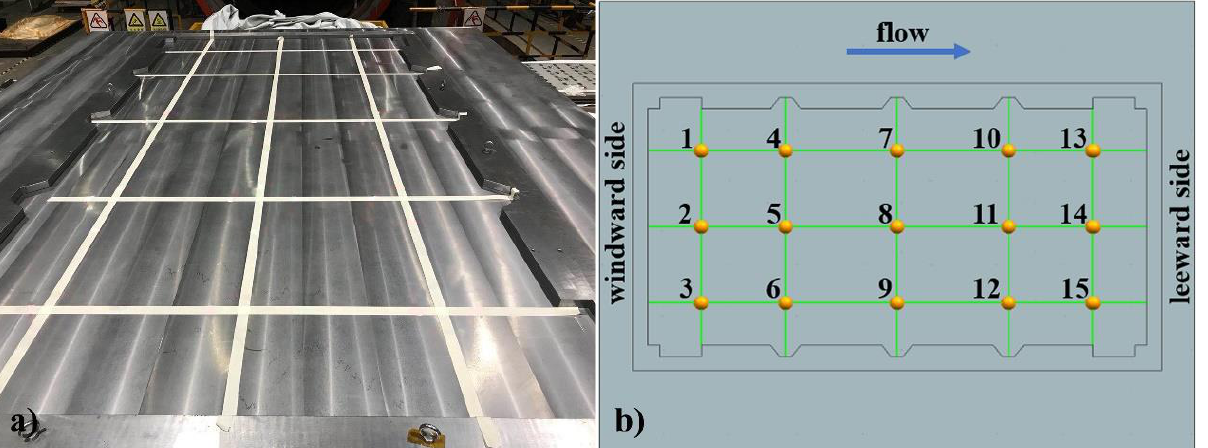
Figure 2. ( a ) Large framed mold; ( b ) Distribution of thermocouples.